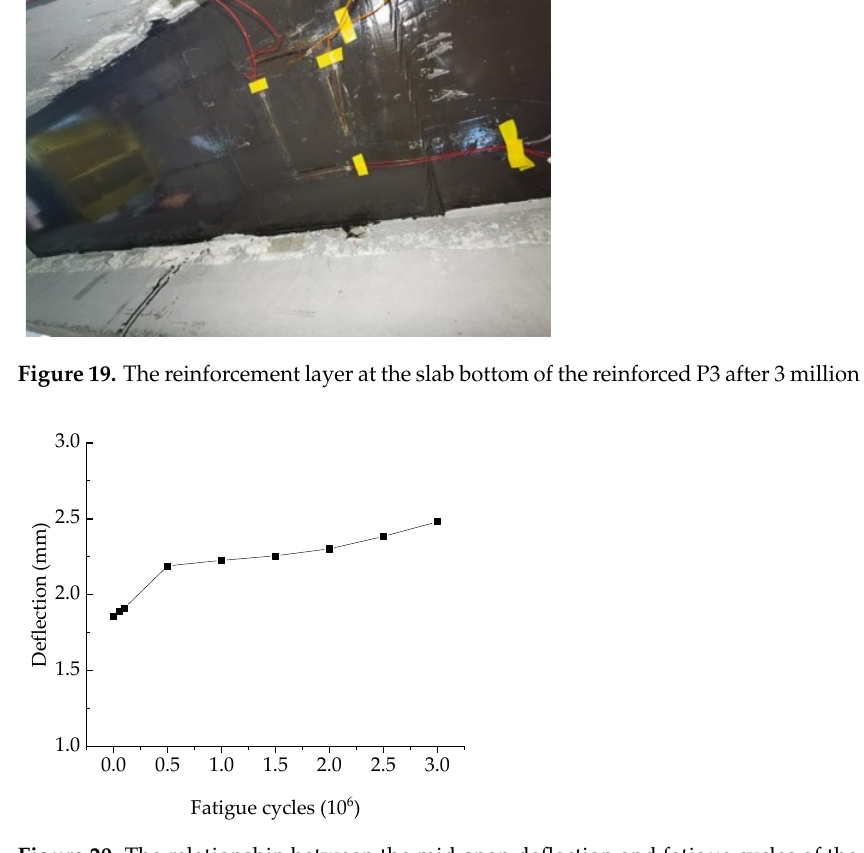
Figure 21. The relationship between the reinforcement strain and fatigue cycles of the reinforced P3.